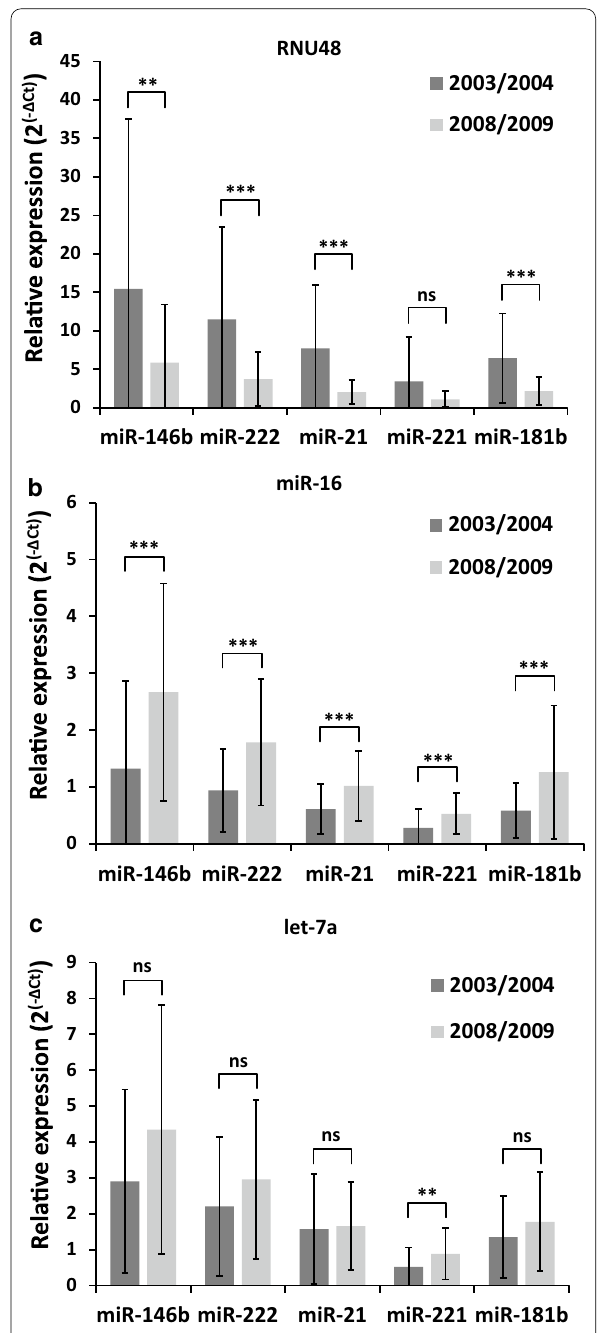
Fig. 1 Differences in miR-146b, miR-222, miR-21, miR-221, miR-181b expression levels between FFPE PTC tissue samples prepared in 2003, 2004 (n 46) and 2008, 2009 (n 31) when normalized with = = different ECs: a RNU48, b miR-16 and c let-7a. Relative expression of miR-181b shown in the graphs was multiplied by 2000. All data are presented as the mean SD. *p < 0.05, **p < 0.01, and ***p < 0.001. ns ± not